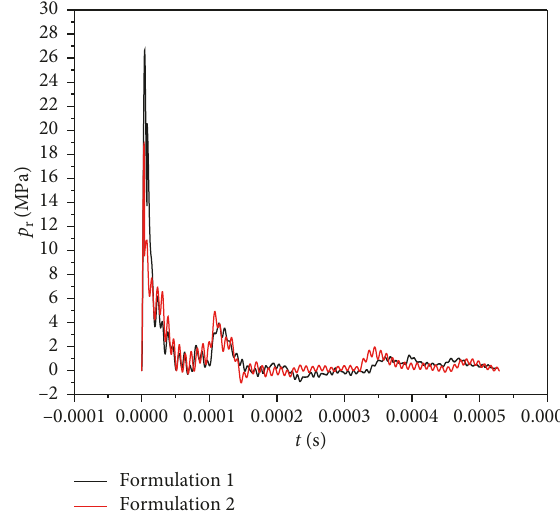
Figure 5: Pressure-time curve of the first incident shock wave.